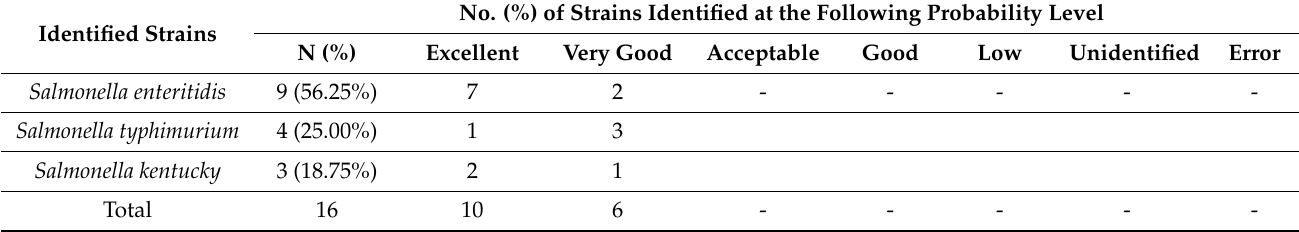
Table 2. Results showing Salmonella spp. identification and their probability level from the VITEK ® 2 ID-GNB identification card (bioM é rieux. Marcy l’Etoile,